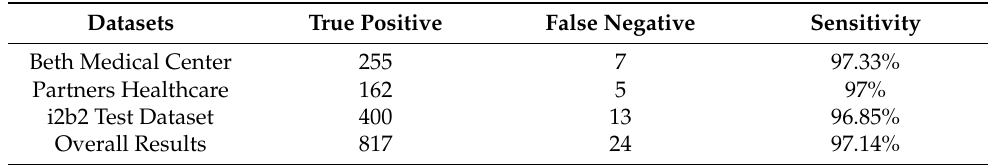
Table 6. Overall datasets and individual performance on the i2b2 datasets for word-boundary identification